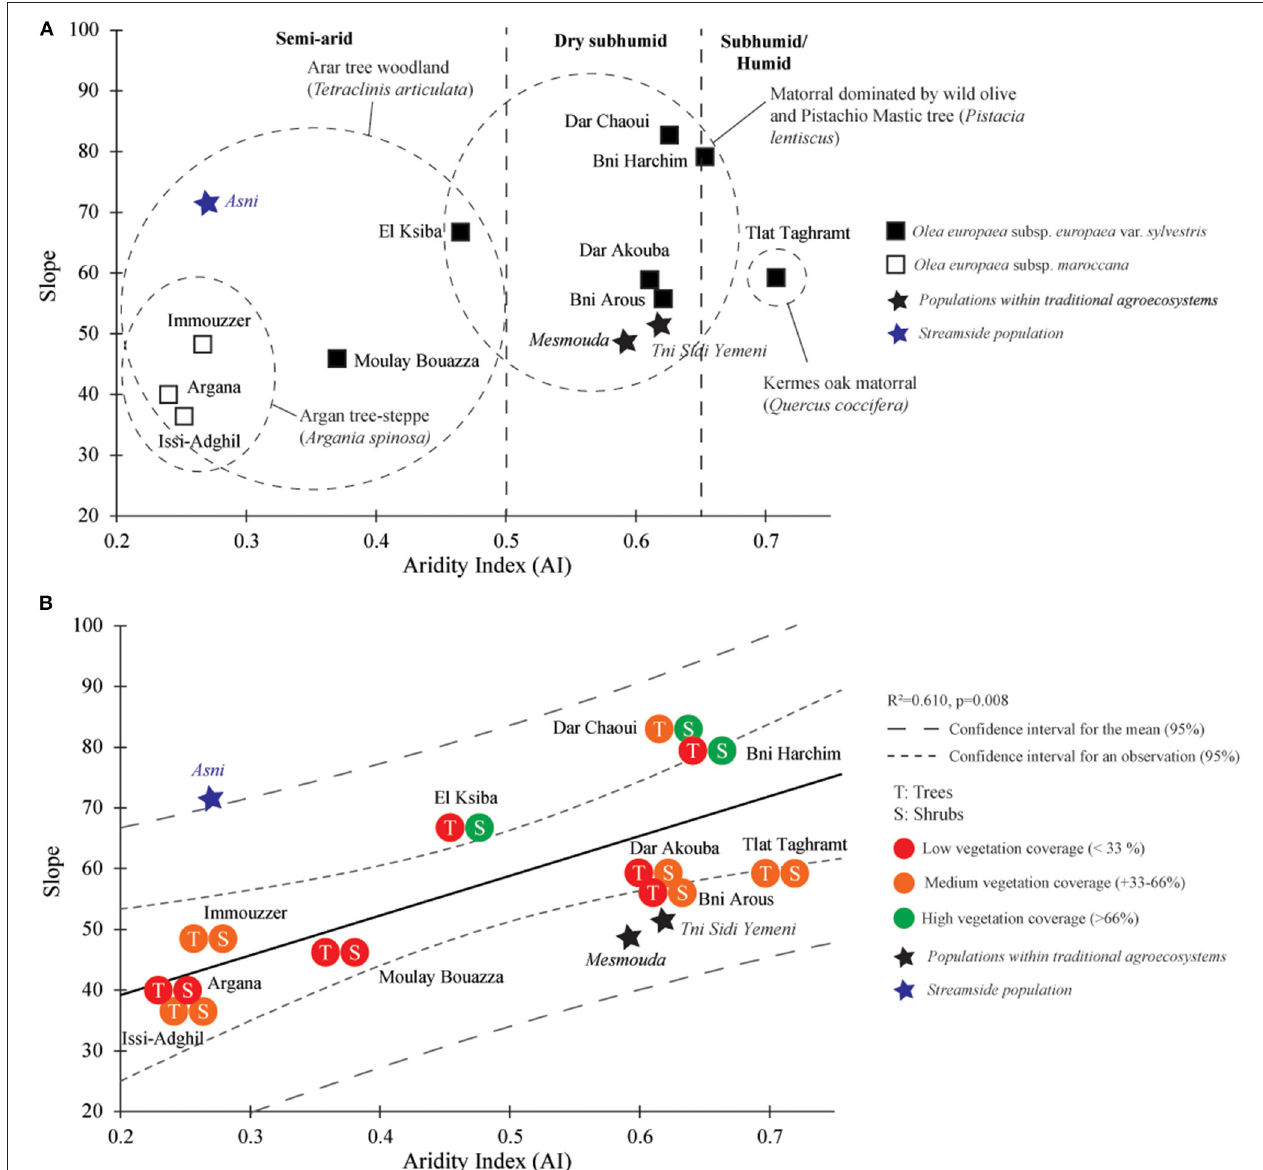
FIGURE 4 | (A) Biplot separating contrasted populations using the aridity index (AI) and slope of fitted lines from regression analysis relating vessel surface area (SVS) and branch diameter (BD). (B) Linear regression model of variation in slope of fitted lines from regression analysis relating SVS and BD.